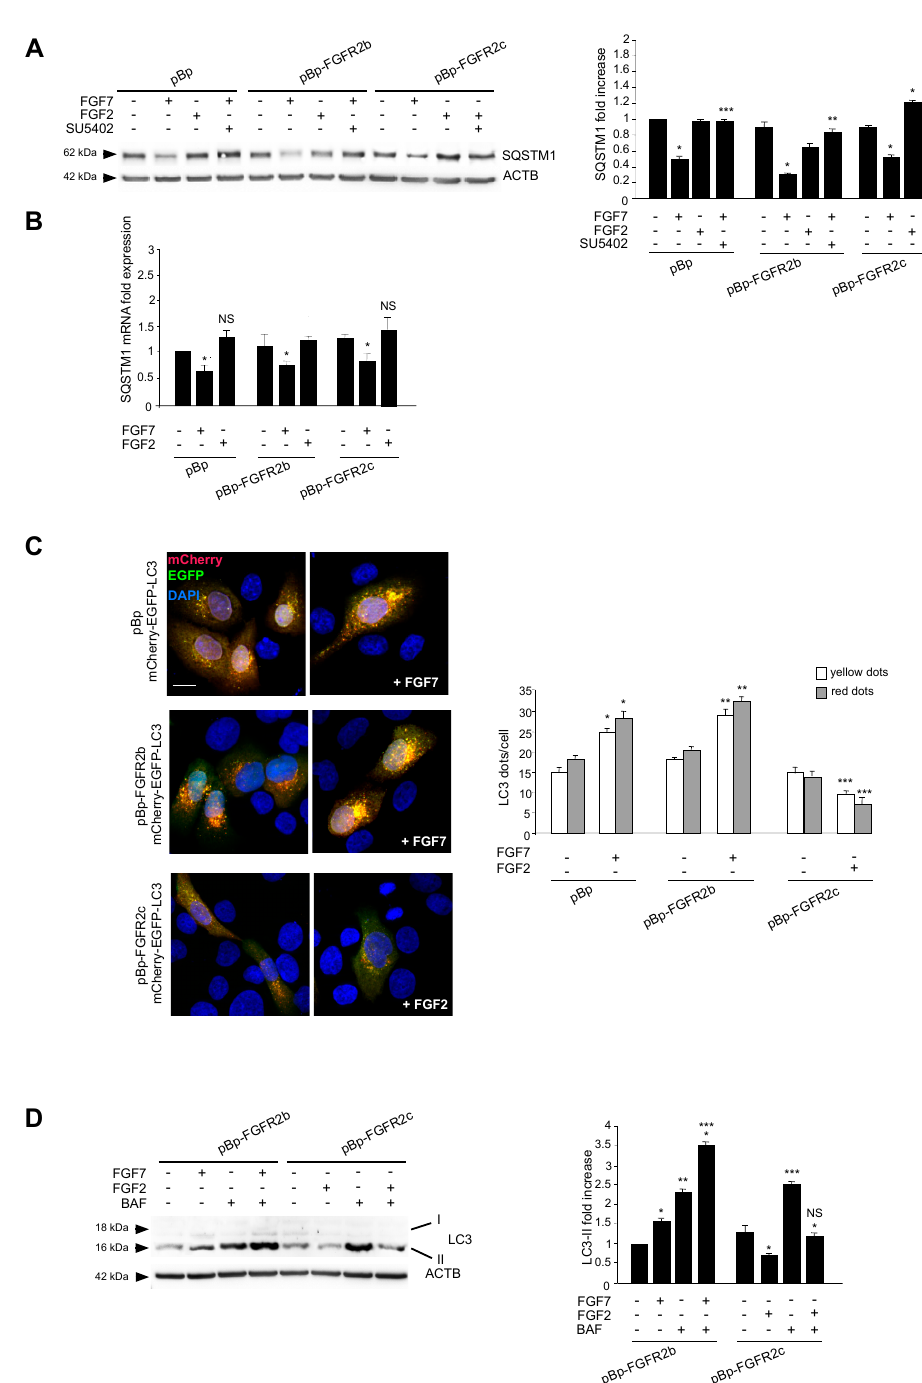
Figure 2. FGFR2c expression and signaling inhibits the autophagosome formation. ( A ) HaCaT pBp, pBp-FGFR2b or pBp-FGFR2c cells were left untreated or stimulated with FGF7 or FGF2 in presence or absence of the FGFR2 tyrosine kinase inhibitor SU5402 as above. Western blot analysis shows that, the 62 kDa band corresponding to SQSTM1 was significantly increased only in HaCaT pBp-FGFR2c clones after FGF2 stimulation, while it decreases in all clones upon FGF7 stimulation. All the observed effects were abolished by SU5402. Equal loading was assessed with anti-ACTB antibody. Densitometric analysis and the student’s t test were performed as reported above. * p < 0.05 vs the corresponding FGF-unstimulated cells; ** p < 0.05 and *** p < 0. 001 vs the corresponding SU5402-untreated cells. ( B ) HaCaT clones were stimulated with FGFR2 ligands as above. Real-time RT-PCR analysis shows that FGF7 stimulation